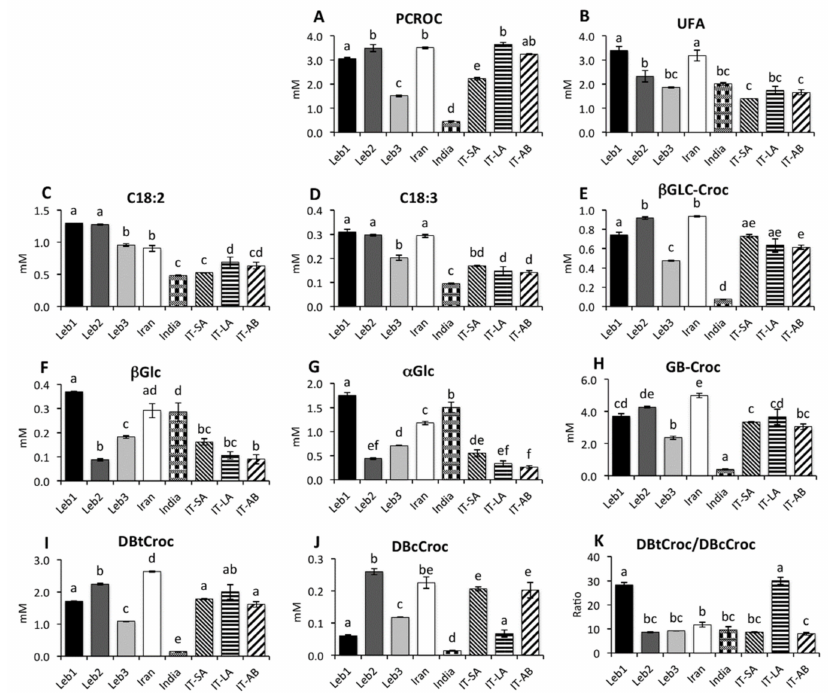
Figure 2. Bar charts relative to concentration (in mM, mean ± SD) of selected components in saffron CD 3 OD extracts obtained by MAE method. ( A ) Picrocrocin, ( B ) unsaturated fatty acid, ( C ) Linoleic fatty acid, ( D ) Linolenic fatty acid, ( E ) β -D-glucosylcrocins, ( F ) α -Glucose, ( G ) β -Glucose, ( H ) β -D- gentiobiosylcrocins, ( I ) All-trans-crocetin, ( J ) 13-cis-crocetin, ( K ) All-trans-crocetin/13-cis-crocetin ratio. Different single letters on the top of the bars (a, b, c, d, e, f) indicate significantly different mean values at p <